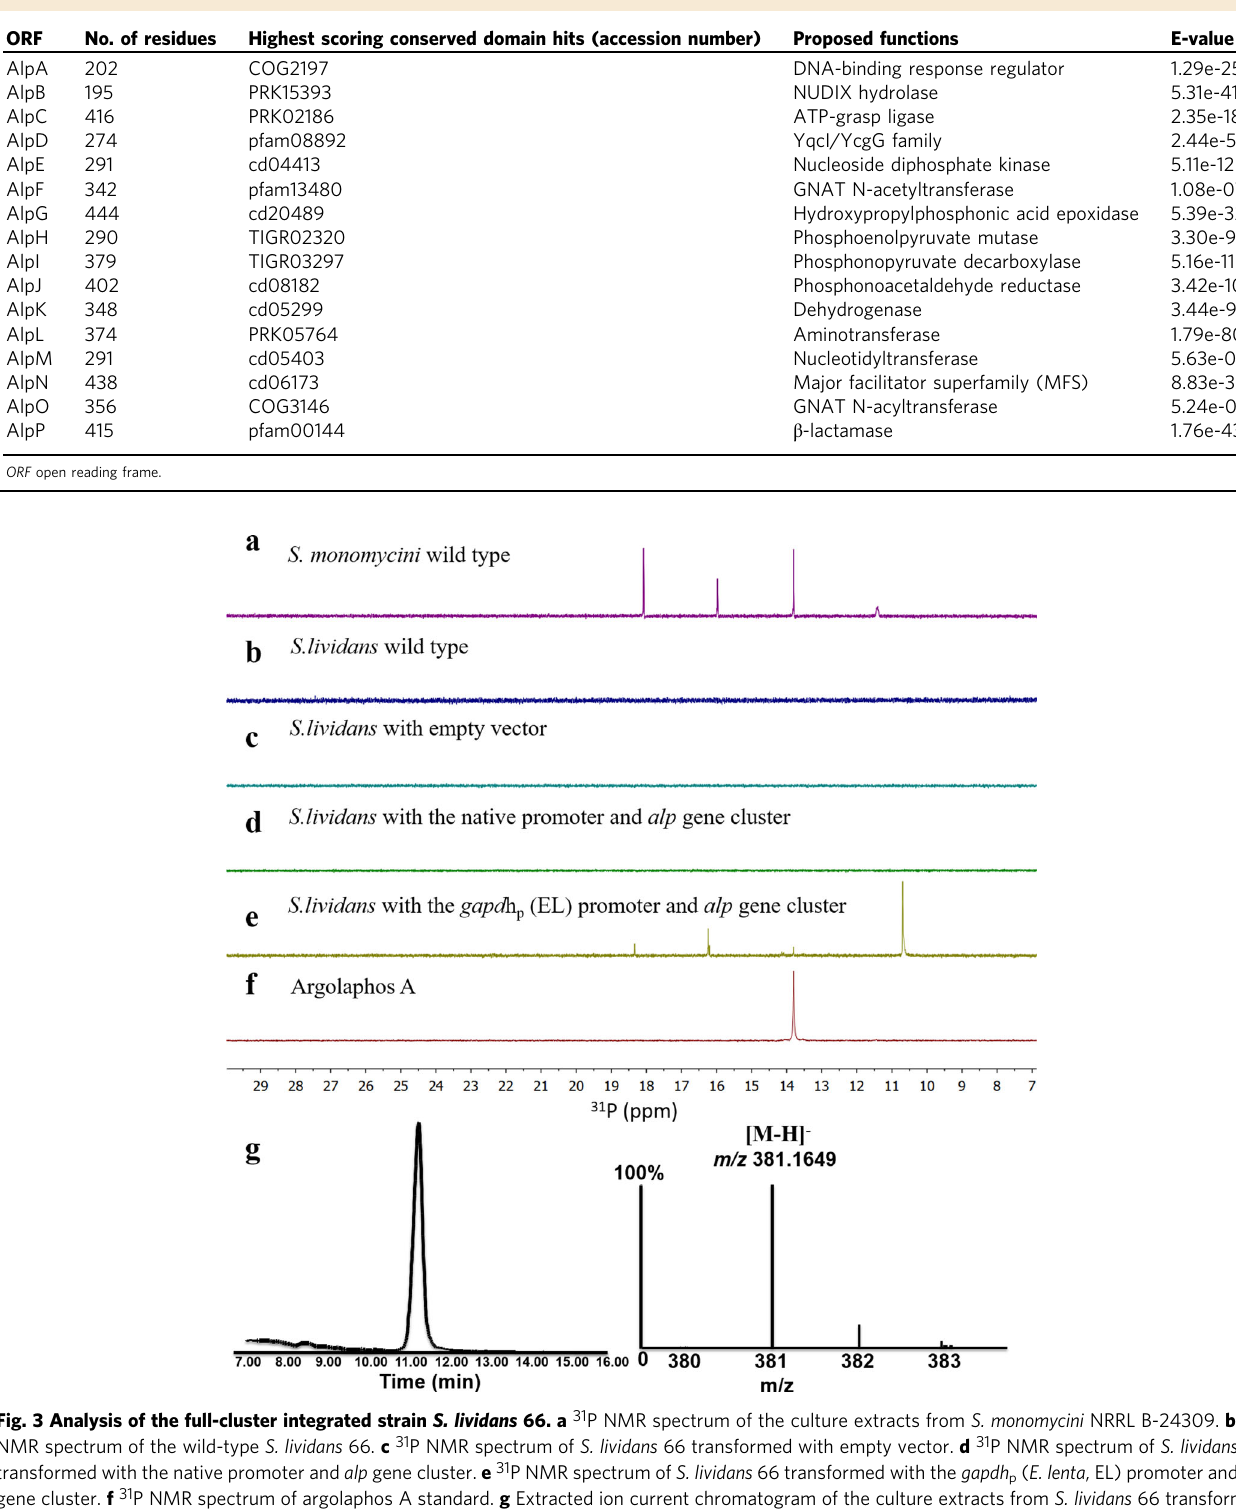
Table 1 Summary of open reading frames in the genomic DNA of S. monomycini NRRL B-24309 that includes the argolaphos biosynthetic gene cluster.